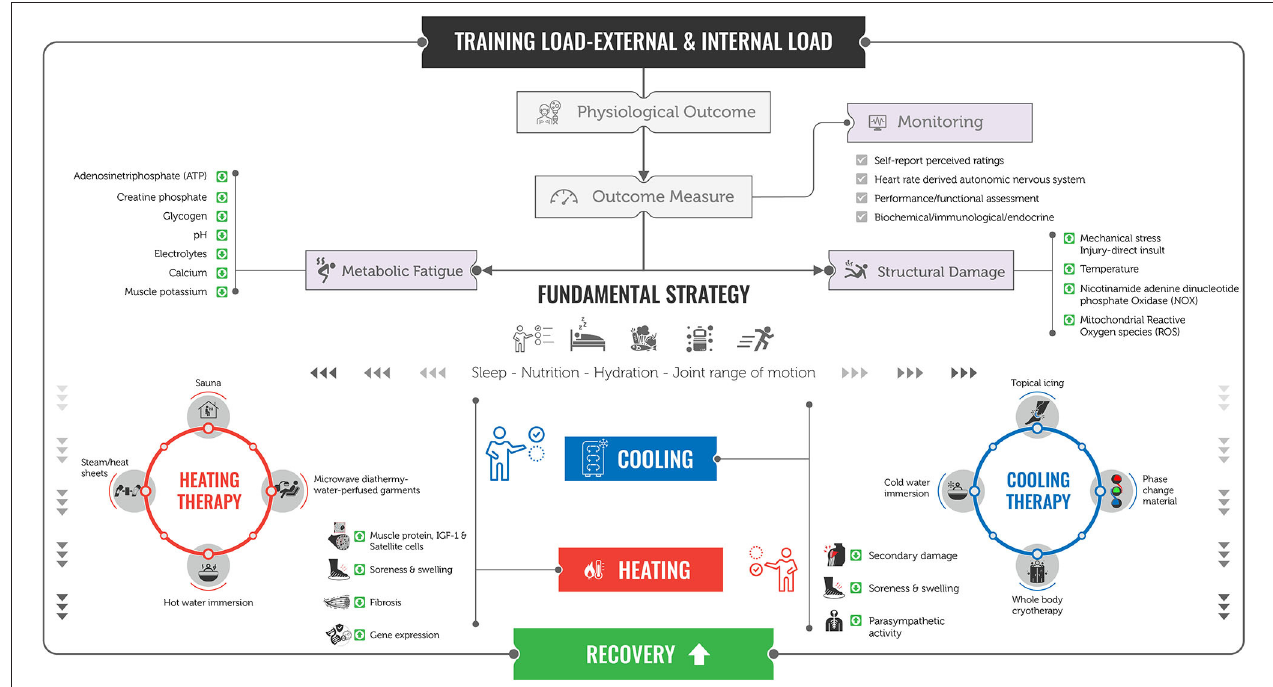
FIGURE 1 | Practical framework to enhance recovery in athletes. Following external and internal load–stress response outcome measures, including, self-report [soreness (DOMS), perceived fatigue, sleep quality]; heart rate-derived autonomic nervous system [heart rate variability (HRV), heart rate recovery (HRR), submaximal heart rate (HRex)]; performance/neuromuscular functional assessment (force–time jump, eccentric, concentric, isometric protocols); and biochemical/immunological/endocrine (creatine kinase, IL-6, C-reactive protein) may be used to distinguish limiting components of physiological fatigue systems {structural damage [mechanical stress, direct insult, increases in temperature and nicotinamide adenine dinucleotide phosphate oxidase (NOX), and mitochondrial reactive oxygen species (ROS)] and metabolic fatigue [ fluctuations in adenosine triphosphate (ATP), creatine phosphate, glycogen, pH, electrolytes, calcium, and muscle potassium]} following exercise and injury. Following an initial fundamental strategy ( optimal sleep, nutrition, hydration, and joint range of movement) the use of cooling (topical icing/phase change material, cold water immersion, whole body cryotherapy) and heating (sauna, microwave diathermy water-perfused garments, hot water immersion or steam/heat sheets) strategies may be used systematically and independently to match the stress to assist in alleviating structural damage (secondary damage, soreness, swelling, and parasympathetic reactivation) and/or metabolic fatigue (muscle protein, IGF-1, satellite cells, soreness, swelling, fibrosis, and gene expression),